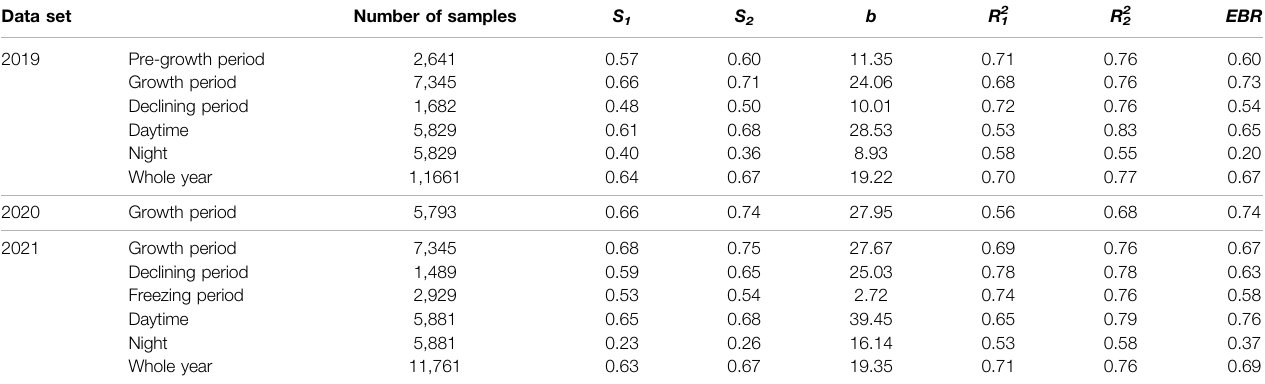
TABLE 5 | Characteristics of energy closure of the Inner Mongolian desert ecosystem at the half-hour scale. Data set